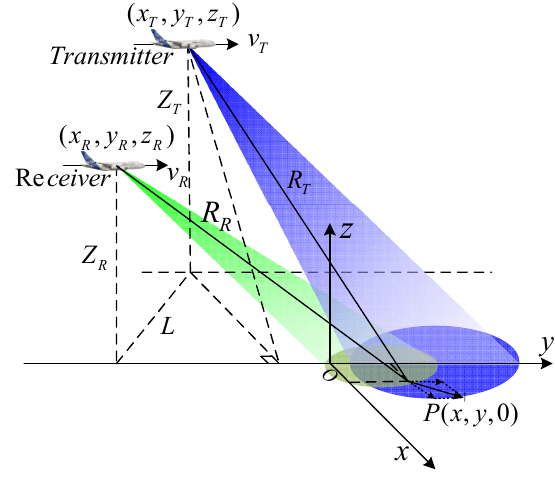
Figure 1. The geometry configuration of BFSAR.